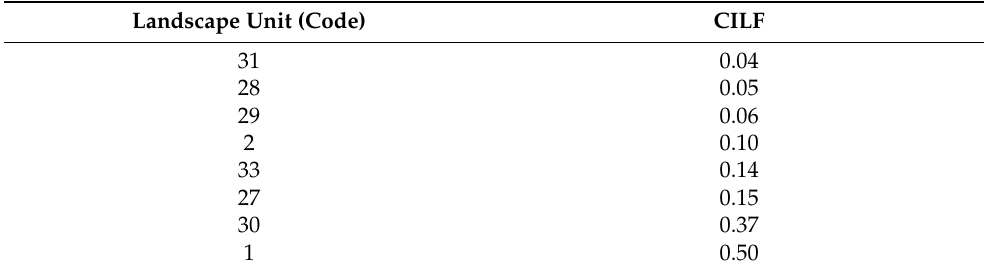
Table 3. Composite indicator of landscape fragmentation (CILF) by RLP landscape unit included in the MC of